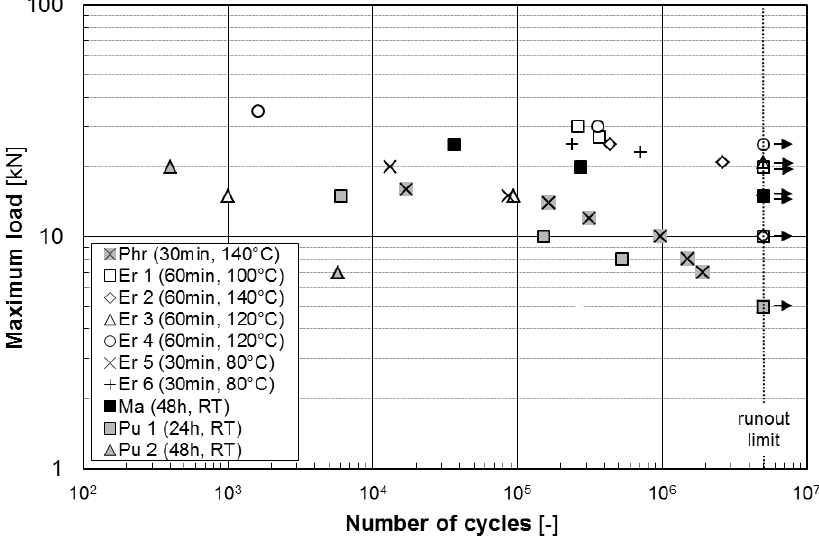
Figure 7. Fatigue lives of single lap-shear-specimen bonded with different adhesive systems